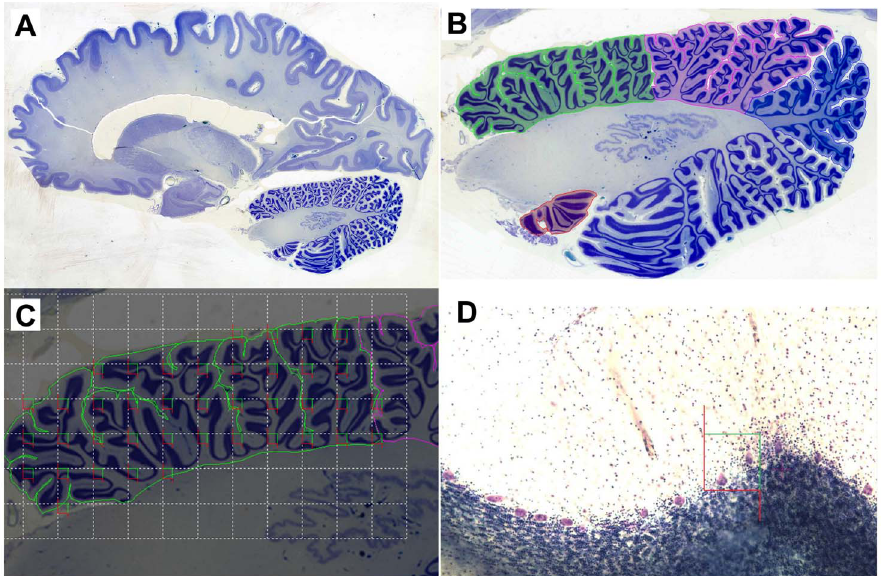
Figure 2. Stereological Assessment of PC Density. This figure depicts our stereological approach for quantifying PC density in each region of the cerebellum. 2a displays a full sagittal section of the human brain. 2b represents the positioning of contour lines used to select the boundaries around each region of interest, within which sampling occurs. Lobules IV–VI are highlighted in green, crus I is highlighted in pink, crus II is highlighted in blue, and the flocculus of lobule X is highlighted in orange at the bottom of the section. 2c displays a hypothetical placement of counting frames (optical disector probes) within lobules IV–VI. The counting frame size has been increased to aid in visualization for this example. The white dotted line displays the randomly imposed grid over the contour, which regulates the distance between counting frames along the X–Y plane of the section. A counting frame is placed in the top-left of each grid cell if it will include a portion of the region of interest as designated by the contour line. Finally, 2d displays a histological section with an imposed counting frame that includes two PCs to be counted. The use of the optical disector probe dictates that PCs are counted when within the counting frame or at all touching the green line, but never when cells intersect with the red line.